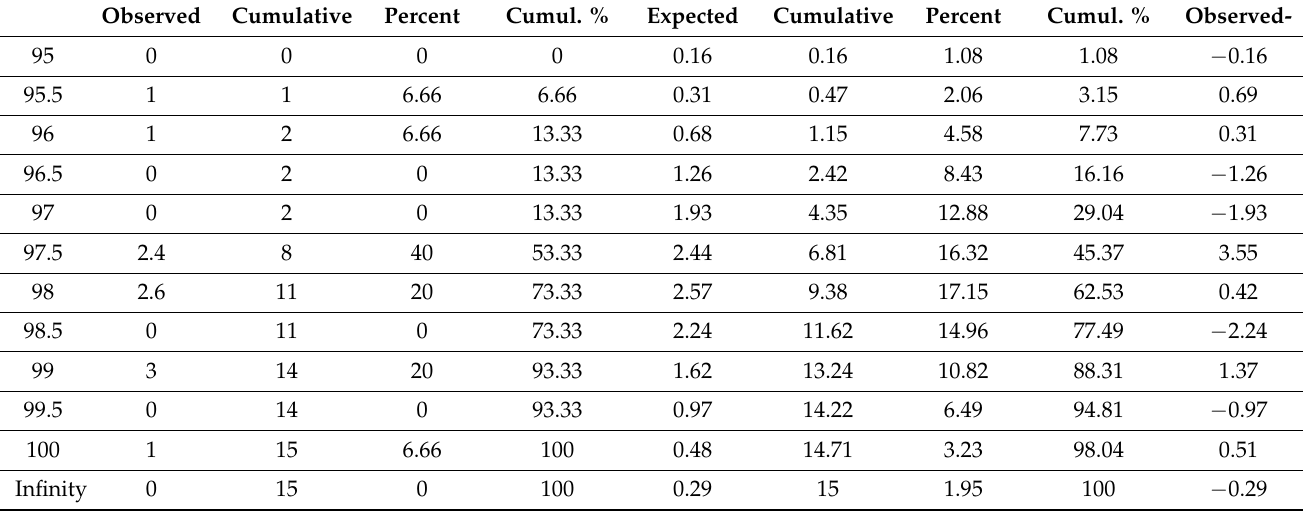
Table 2. Calculation of statistics criterion and distribution of a random variable over intervals.